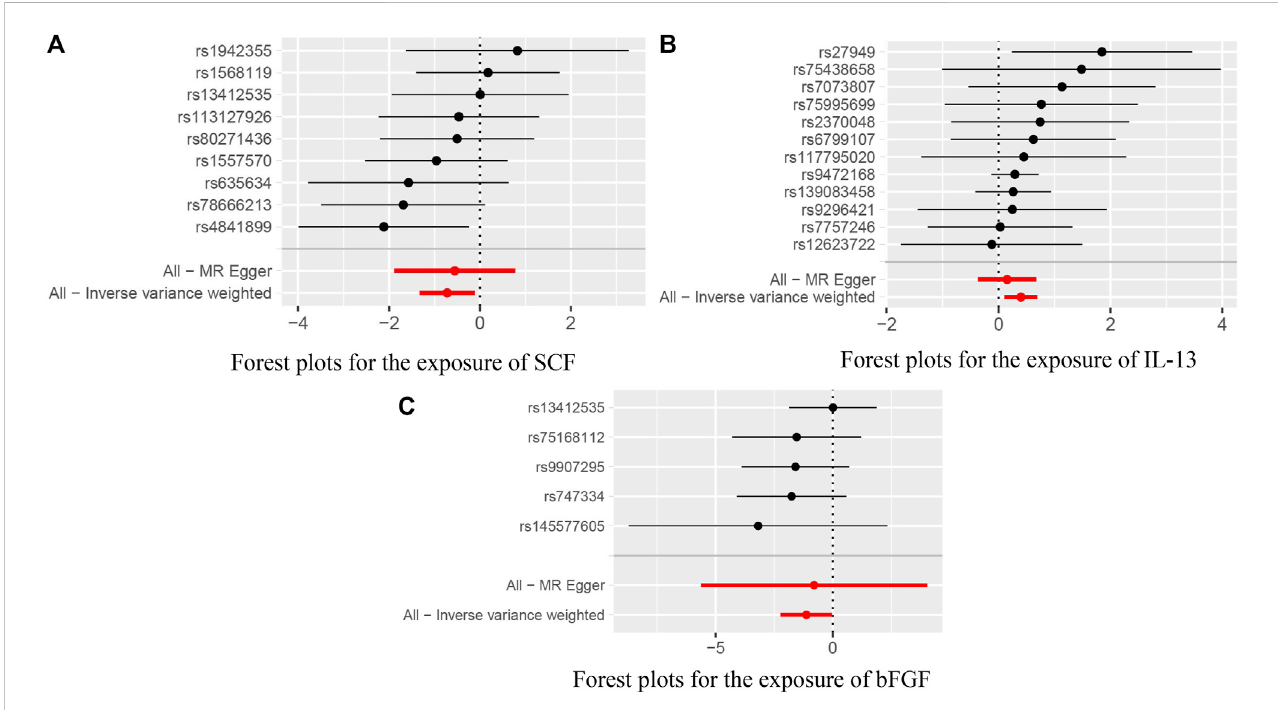
FIGURE 2 (A) Forest plots for the exposure of SCF. (B) Forest plots for the exposure of IL-13. (C) Forest plots for the exposure of